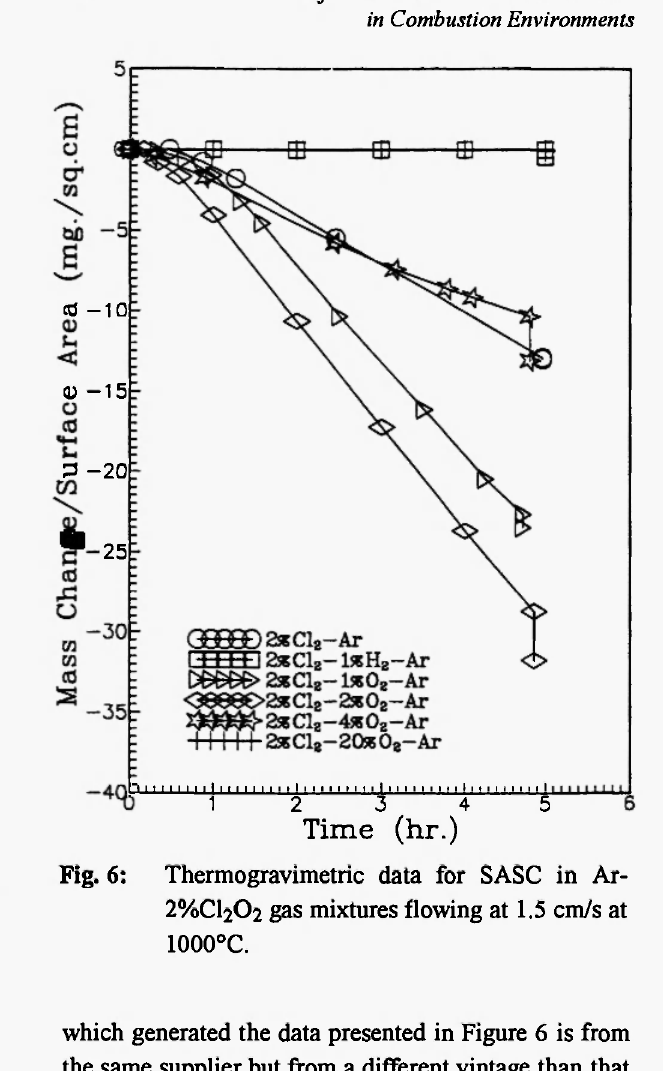
Fig. 6: Thermogravimetric data for SASC in Ar- 2%Cl2C>2 gas mixtures flowing at 1.5 cm/s at